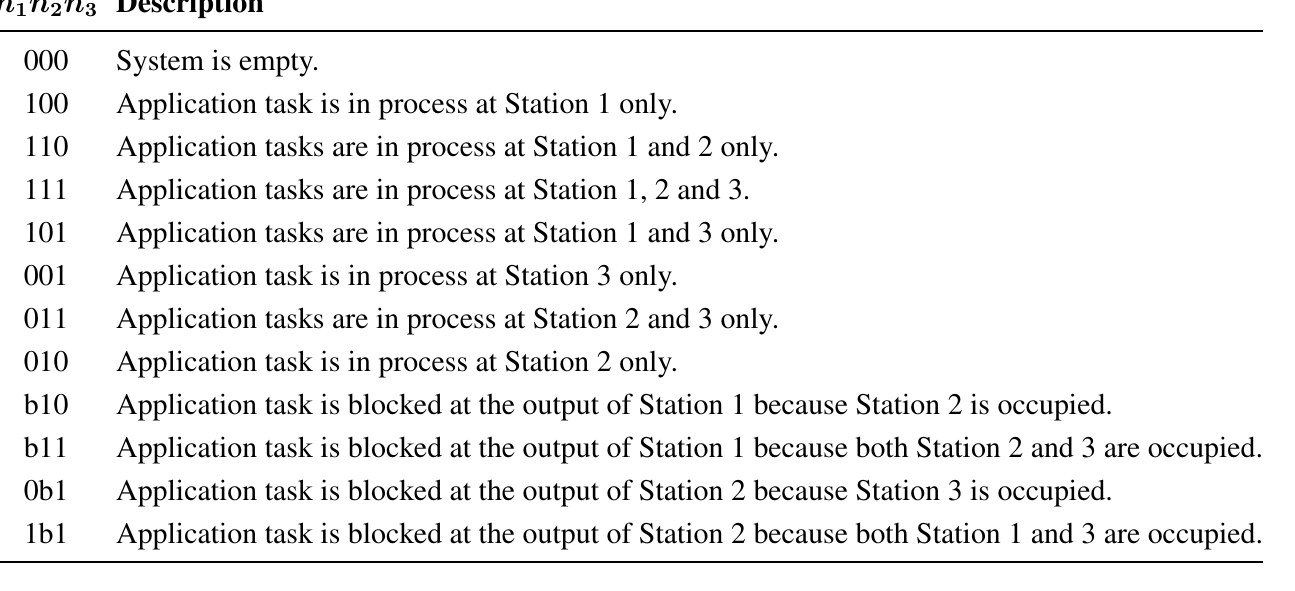
Figure 2. Steady State Transitions on a Computing